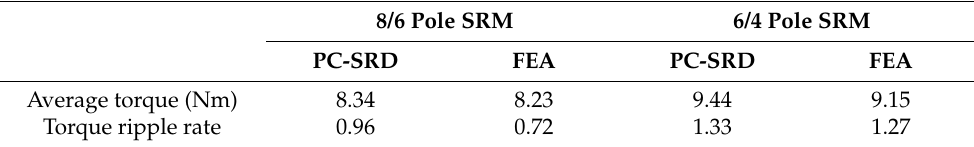
Figure 7. Three-phase current and total torque waveforms of the three-phase 6/4 pole SRM at 2000 rpm calculated from ( a ) PC-SRD; ( b ) FEA. Table 5. Calculated average torque and torque ripple rate of each motor.